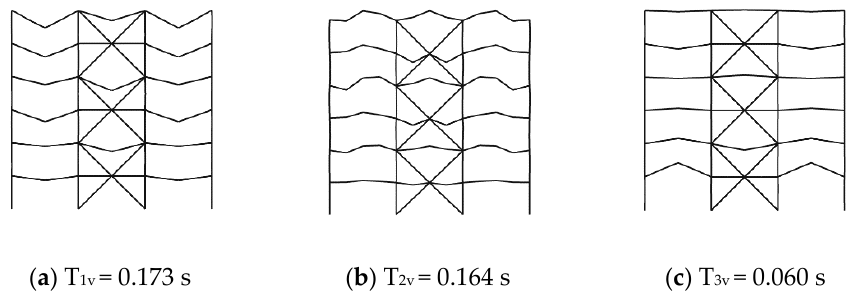
Figure 3. Vertical vibration modes for the six-story building. The computed horizontal and vertical vibration modes in the same order as previously described for the ten-story building are T 1h = 0.841 s, T 2h = 0.238 s and T 3h = 0.121 s, and T 1v = 0.198 s, T 2v = 0.122 s and T 3v = 0.058 s, respectively, which are depicted in Figure 4 for the horizontal modes and Figure 5 for the vertical ones.